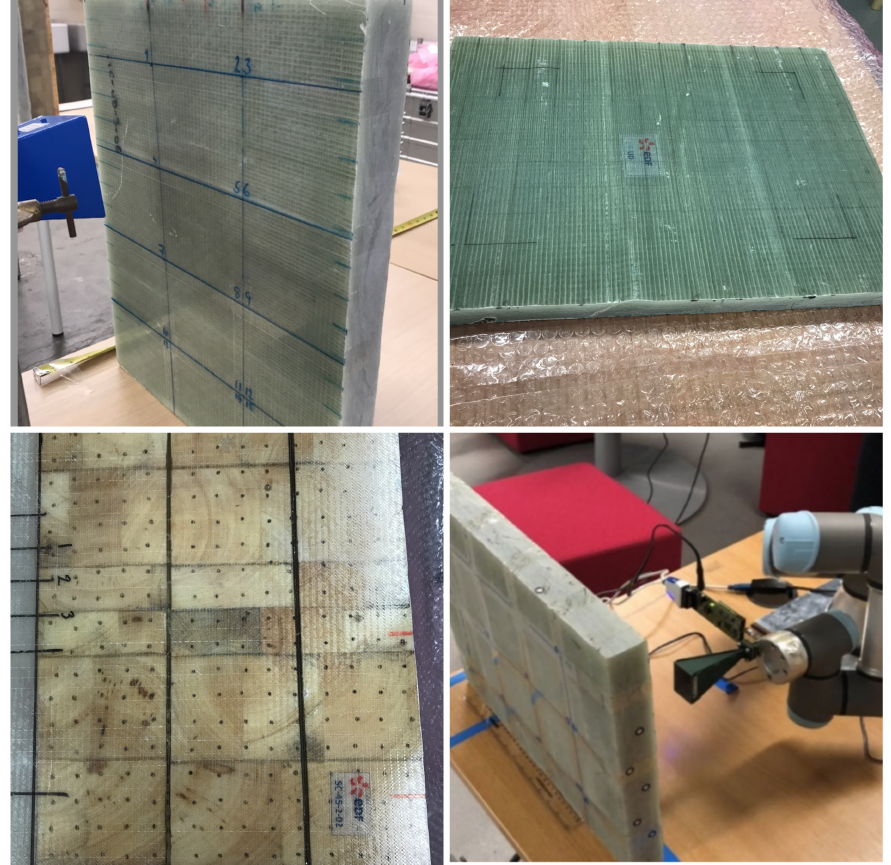
Figure 3. ( top left ) Composite material test sample No.1 with monolithic thickness of 48.7 mm, ( top right ) No.2 with monolithic thickness of 51.2 mm, ( bottom left ) No.3 with sandwich composites with thickness of 27.8 mm, ( bottom right ) Raster scanning on test samples using UR3 robot manipulator